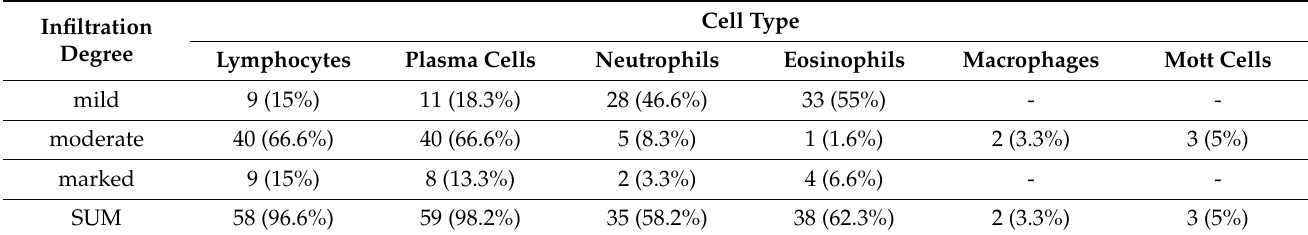
Table 1. Table showing the type of cellular infiltration in the lamina propria of the duodenum, along with its degree, number of horses, and % distribution in the studied horse population.